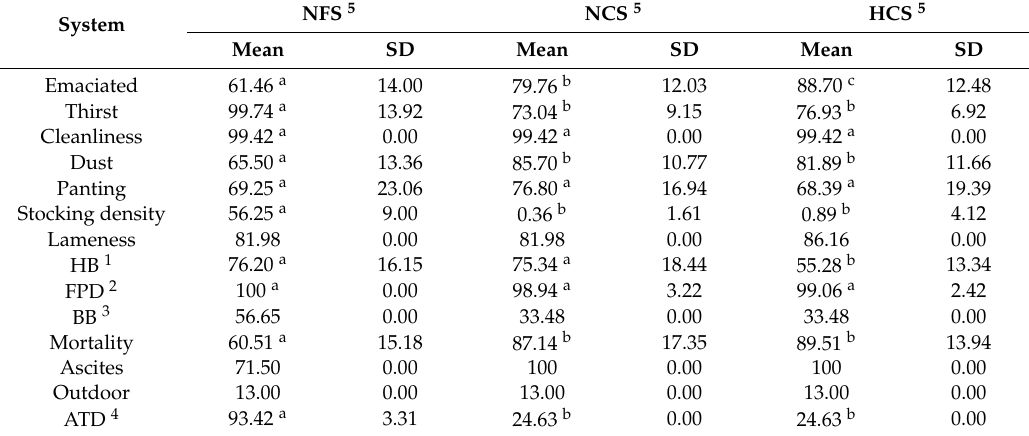
Table 2. Mean welfare score per measure per system type.